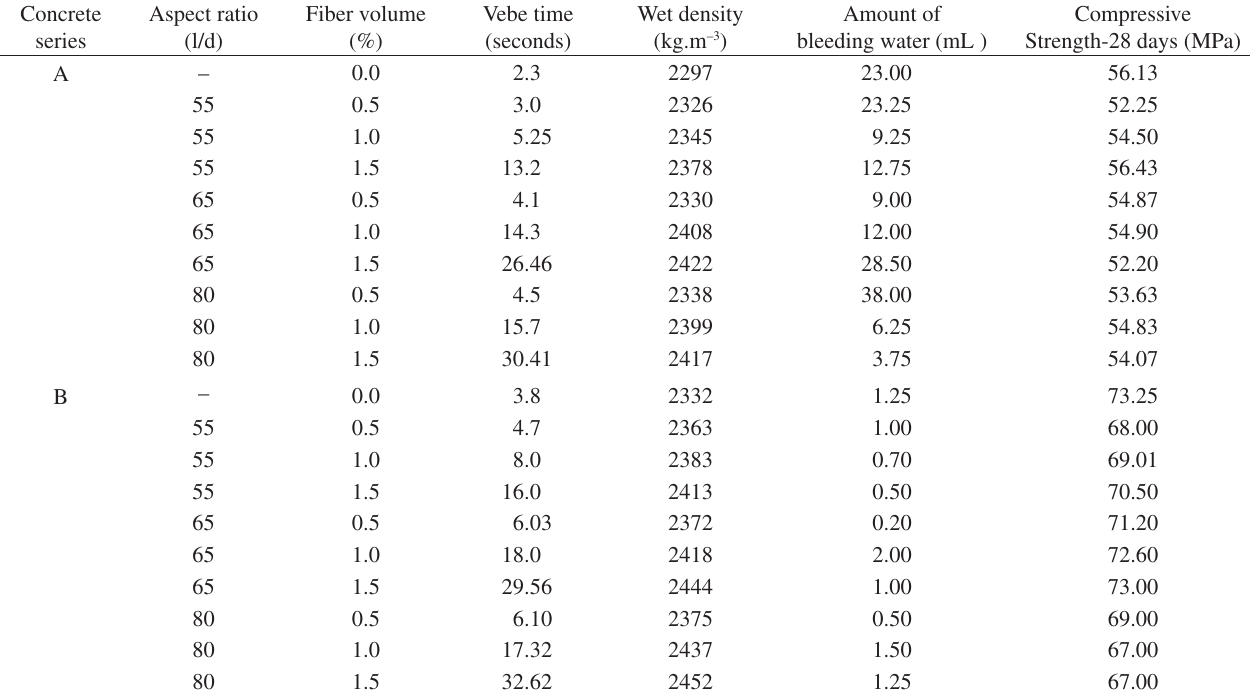
Table 2. Vebe time, wet density, compressive strength, and amount of bleeding water test results. Concrete